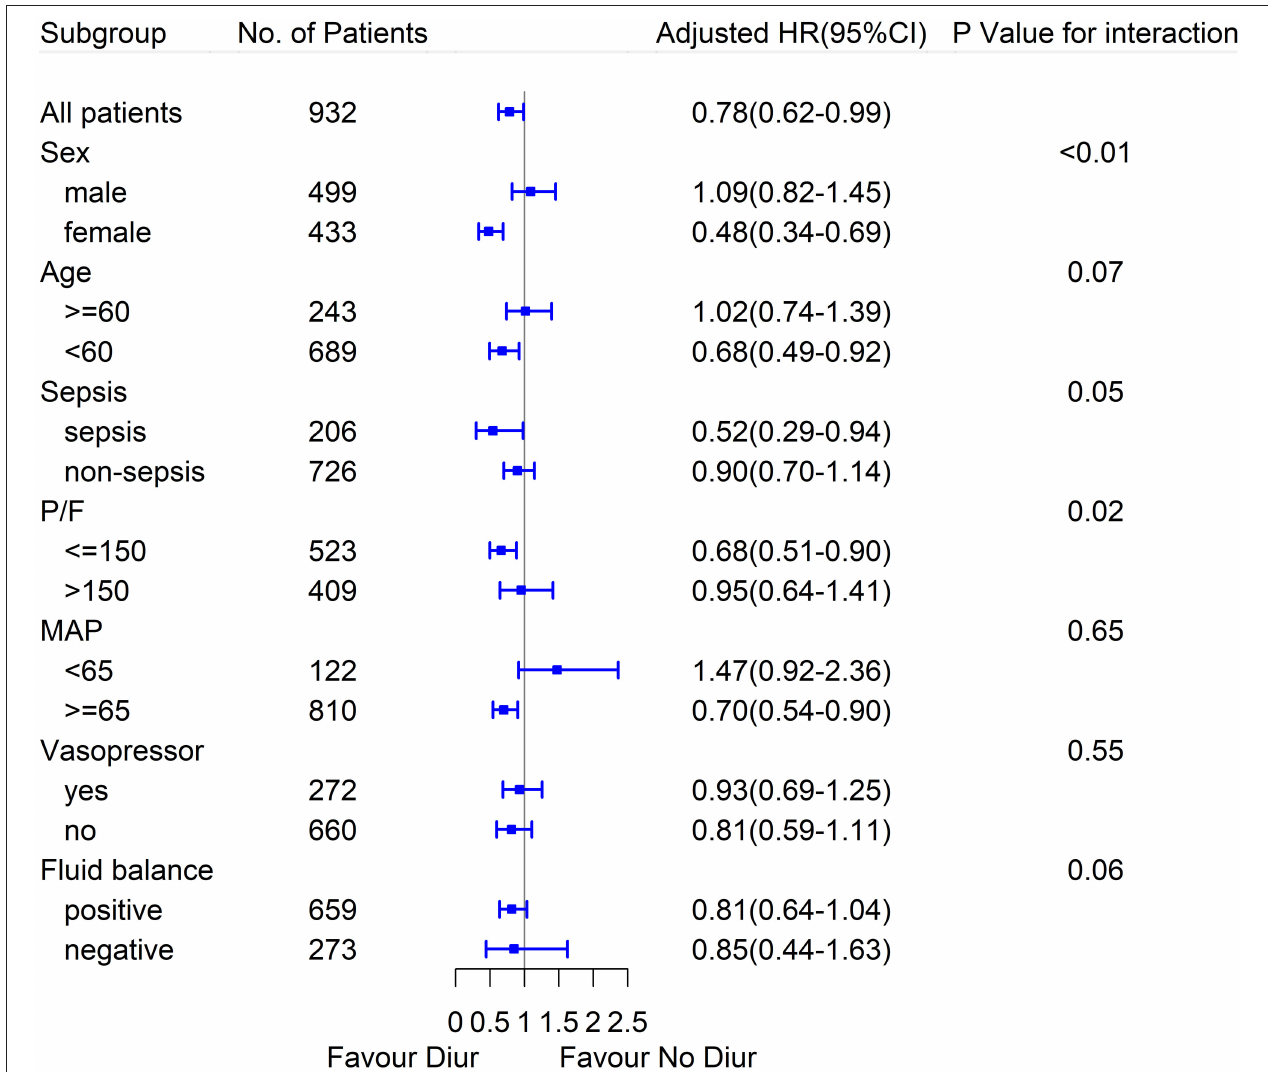
FIGURE 1 | Marginal structural Cox model hazard ratio (HR) values for 28-day mortality in diuretics and no diuretics group according to the subgroups.